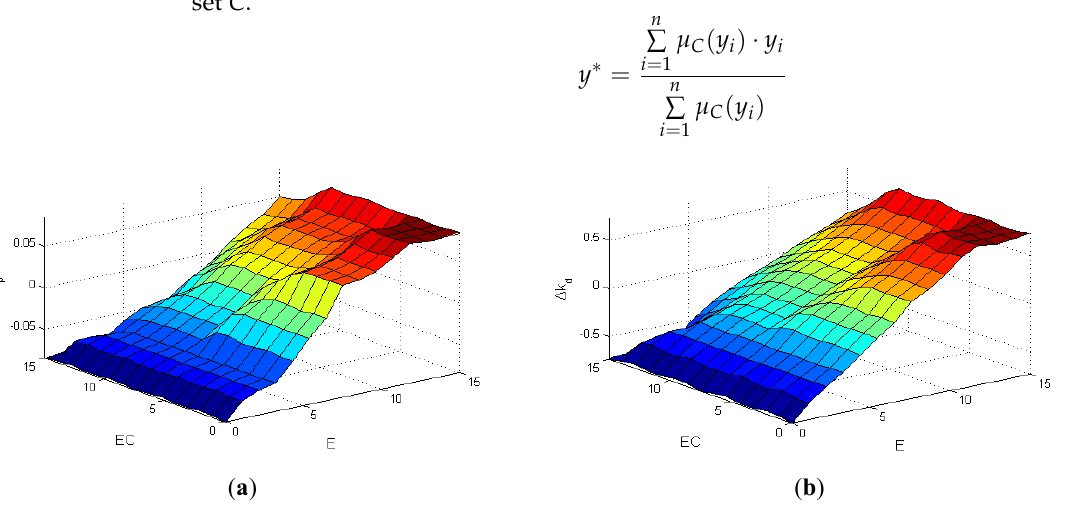
Figure 10. Output surface after defuzzification of fuzzy controller. ( a ) Δ k p Surface, ( b ) Δ k d Surface.